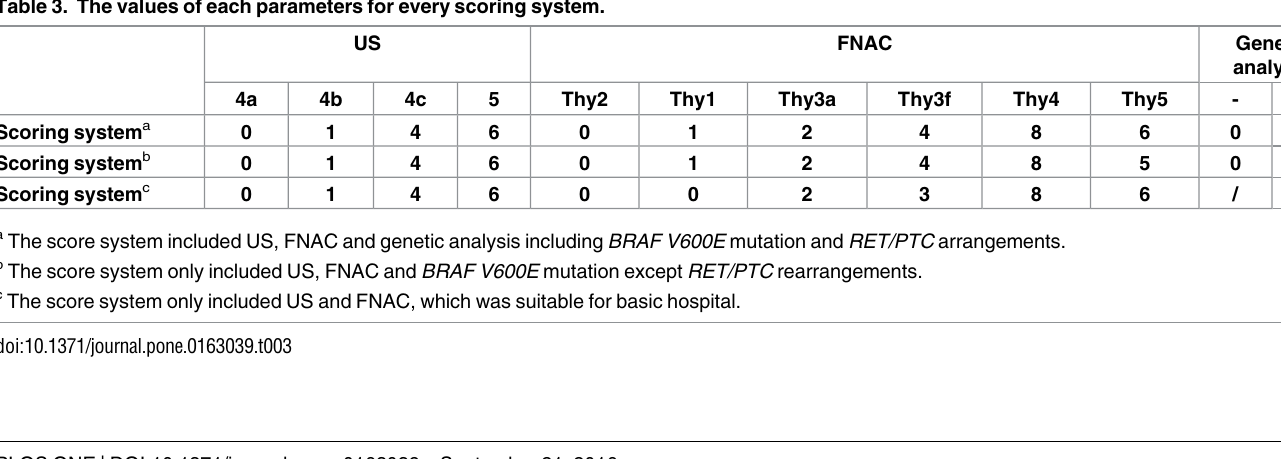
Table 3. The values of each parameters for everyscoring system.